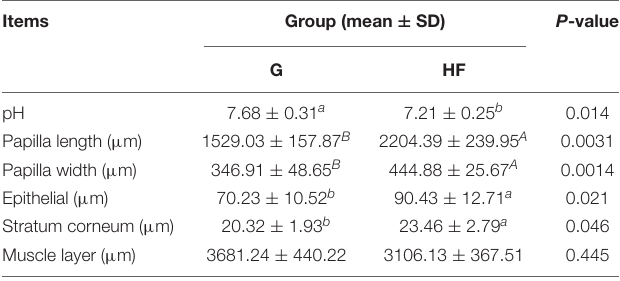
TABLE 2 | Effects of different feeding systems on various indicators of rumen.